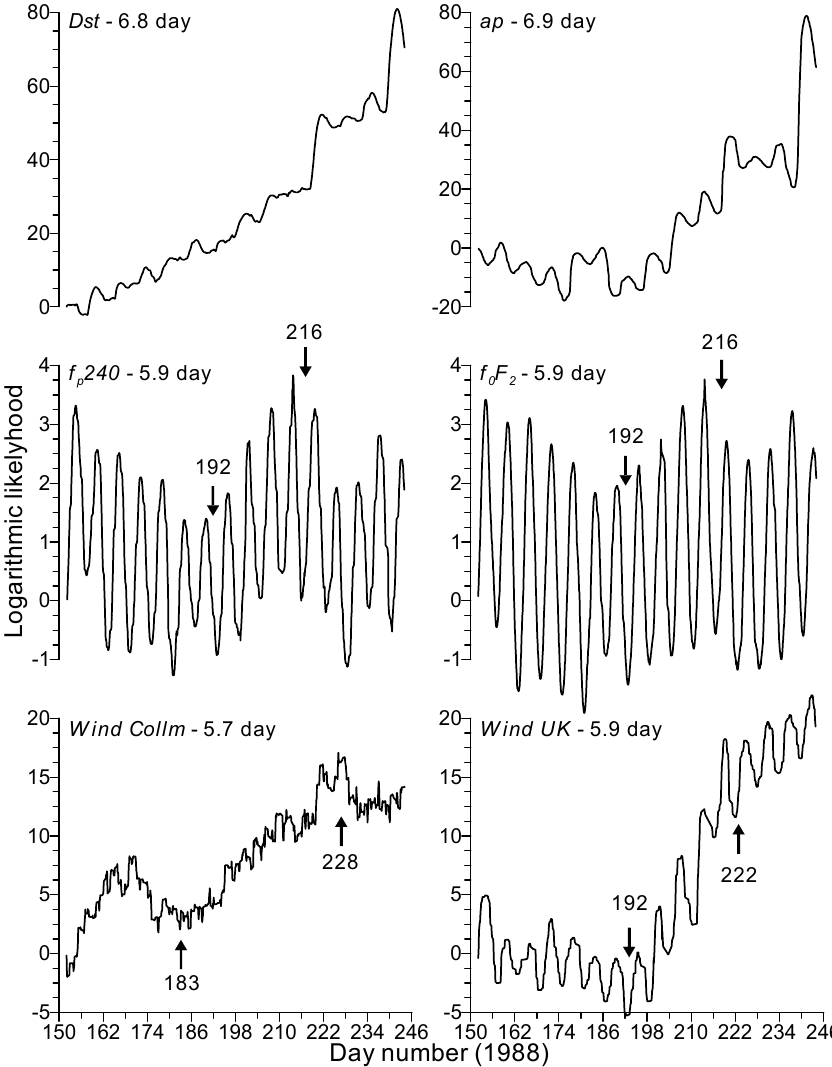
Fig. 5. Time development of the logarithmic likelihood for the dominant periods of each time series in the time interval from 1 June to 31 August 1998. The arrows in the plots indicate the time interval when the oscillations are in